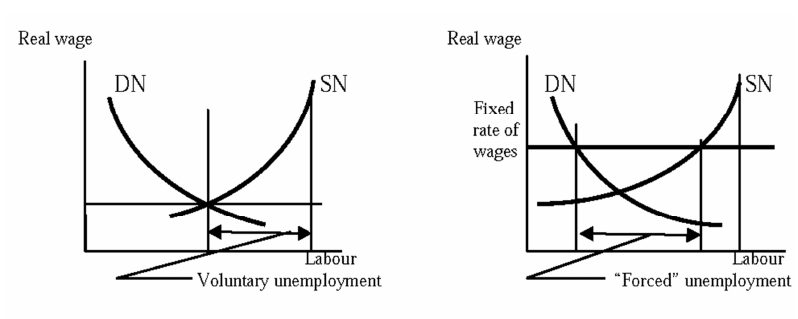
Figure 1. From Davar: Walrasian “voluntary“ (and forced”) unemployment”